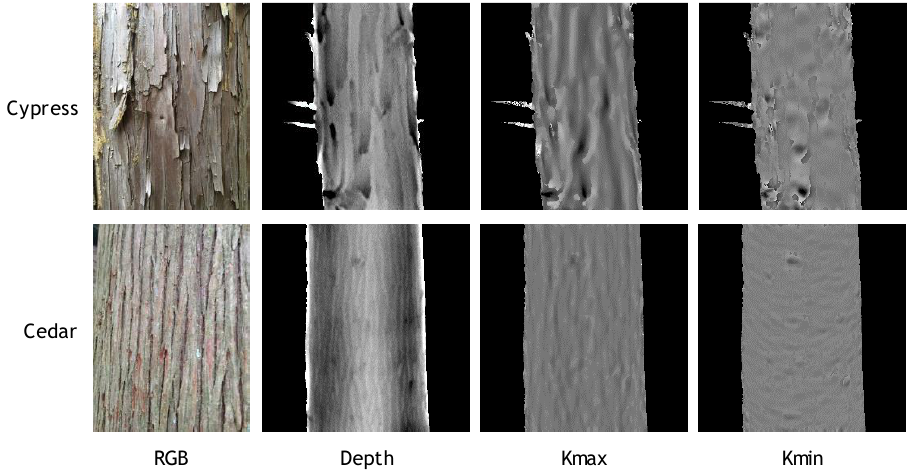
Figure 5. Examples of created depth and curvature images